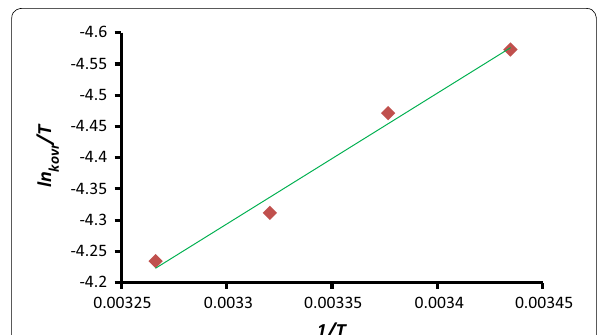
Fig. 7 Eyring plot ( ln k ovr /T versus 1/T ) according to Eq.5 for the reac‑ tion between ( 1 ), ( 2 ) and ( N – H ) compounds in the methanol